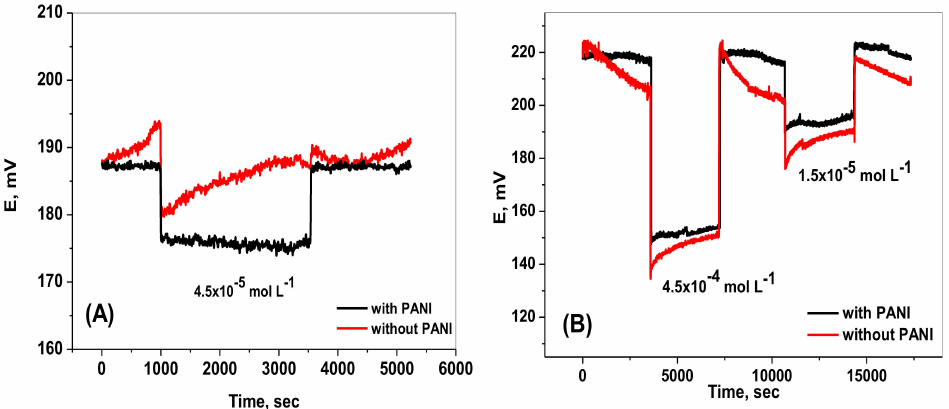
Figure 5. Potential drift due to formation of water layer between ( A ) paper and ( B ) ceramic based chromium(VI) sensors with a PANI solid contact layer and the sensing PVC membrane.